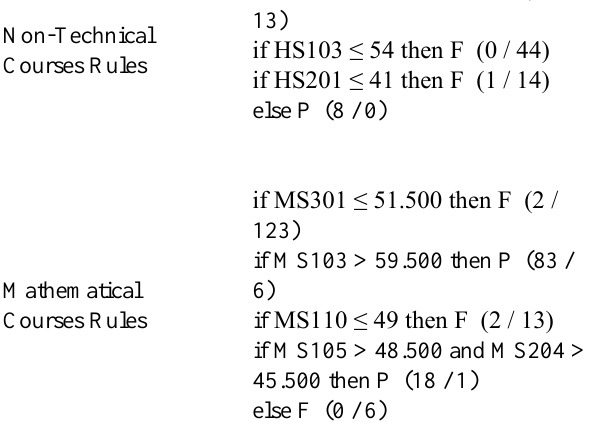
Fig. 15. Decision tree with gain ratio for dataset 2